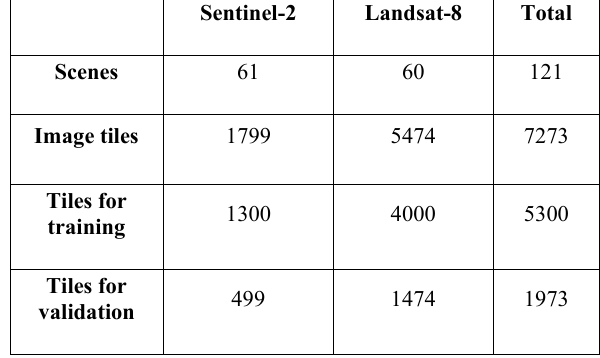
Figure 3. Tiling of the satellite image scenes and cloud mask generation. Table 1: Summary of satellite image scenes and number of image tiles from Landsat-8 and Figure 1. Distribution of the satellite image scenes used in this study.